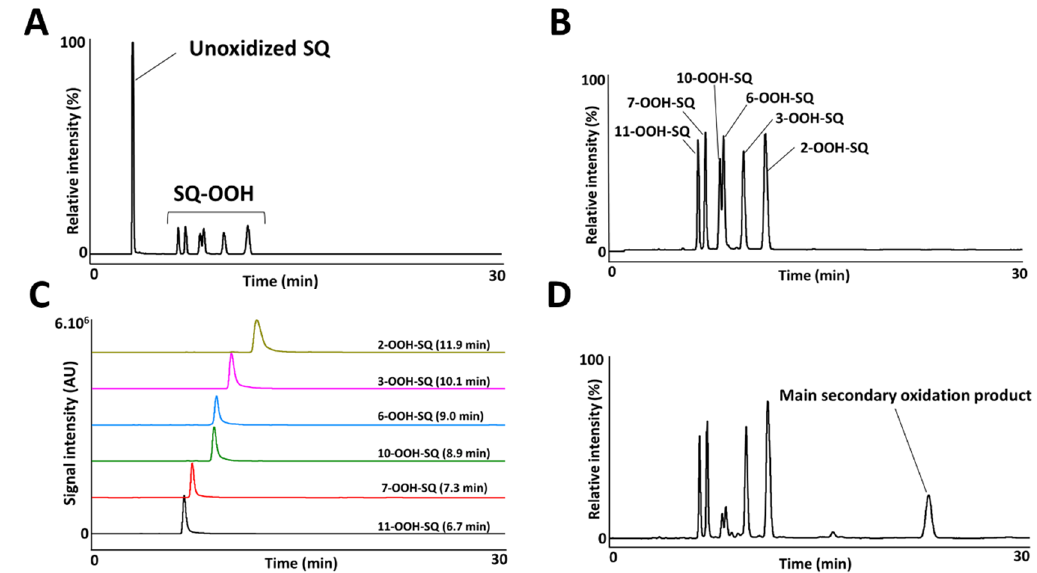
Figure 2. UV-HPLC chromatograms of the crude oxidized SQ ( A ), purified mixture of SQ-OOH isomers ( B ), purified Figure 2. UV ‐ HPLC chromatograms of the crude oxidized SQ ( A ), purified mixture of SQ ‐ OOH isomers ( B ), purified individual SQ-OOH isomers ( C ), and the photooxidized mixture of SQ-OOH isomers ( D individual SQ ‐ OOH isomers ( C ), and the photooxidized mixture of SQ ‐ OOH isomers ( D ).